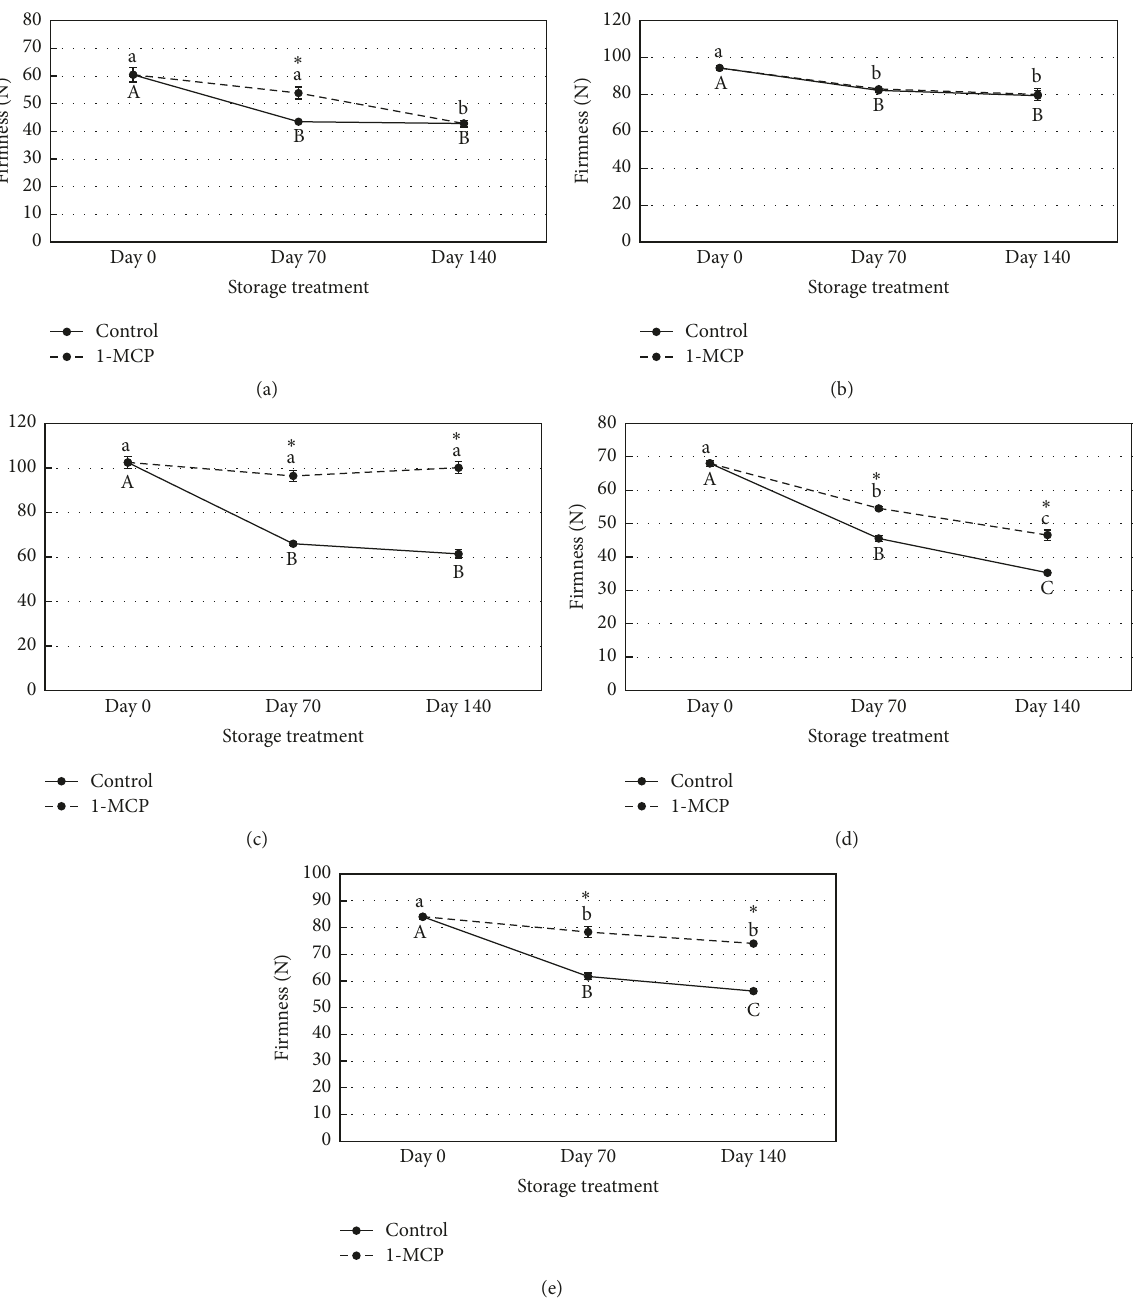
Figure 1: Firmness of apple fruit at (a) “Golden Delicious,” (b) “GoldRush,” (c) “WineCrisp,” (d) “Pixie Crunch,” and (e) “CrimsonCrisp” apples at harvest and 70 or 140 days of storage at 0 ∘ C followed by 7 days at 20 ∘ C. Day 0, at harvest; Day 70, 70 days of storage at 0 ∘ C followed by 7 days at 20 ∘ C; Day 140, 140 days of storage at 0 ∘ C followed by 7 days at 20 ∘ C. Capital letters and lowercased letters indicate mean separation among storage duration treatment of control and 1-MCP-treated apples, respectively, by Tukey’s HSD at 𝑝 < 0.05 . Asterisks ( ∗ ) indicate significant difference between control and 1-MCP treatment in each cultivar at each storage duration using Student’s 𝑡 -test at 𝑝 < 0.05 . Vertical bars represent standard error ( 𝑛 = 4